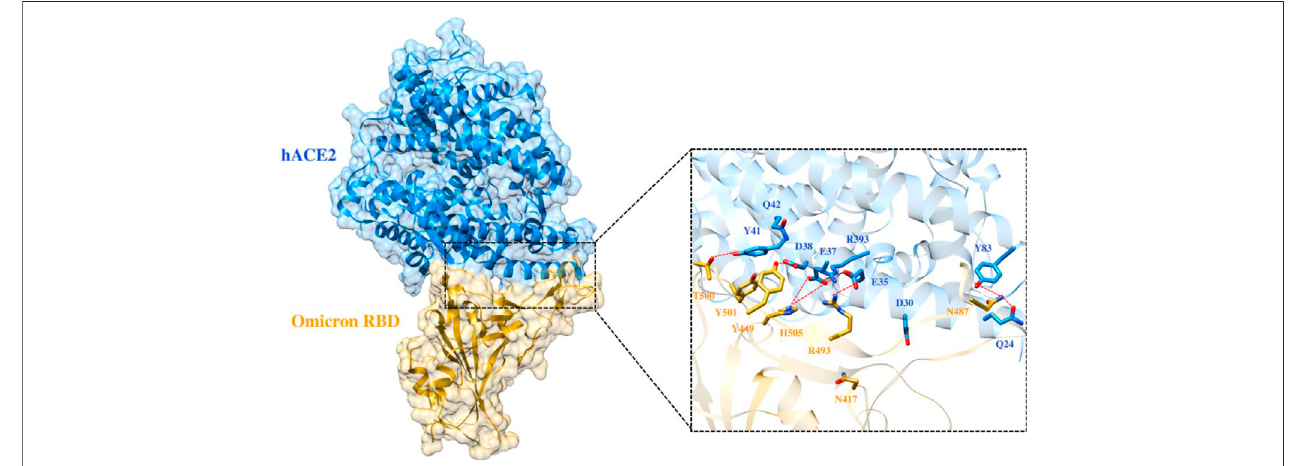
FIGURE 7 | Interfacial binding interactions between Omicron RBD and ACE2 receptor. RBD and ACE2 residues are colored as gold and blue sticks, respectively, while red dotted lines represent the hydrogen bonds.